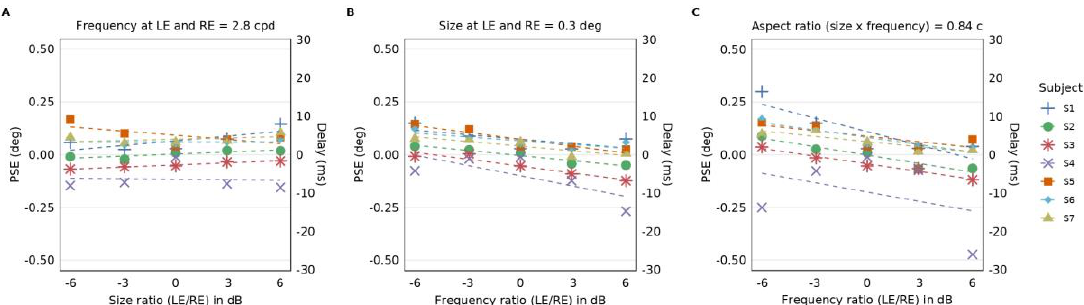
Figure 5. PSEs as a function of either size or spatial frequency ratio between the Gabor elements shown to the left and right eye. ( A ) Individual subjects’ PSEs (in degrees, left y -axis) as a function of the size ratio between the left and right eye’s Gabor elements when the frequency of the Gabor elements presented to both eyes is 2.8 c / d. Dotted lines represent linear regression for each subject. The slope from linear regression of PSEs as a function of the size ratio is not significantly di ff erent from zero (two-tailed Wilcoxon signed rank test: p = 0.47). Right y -axis represents the equivalent delay (in milliseconds). ( B ) Individual subjects’ PSEs (in degrees, left y -axis) as a function of the spatial frequency ratio between the Gabor elements when the size of the Gabor elements presented to both eyes is 0.3 deg. Dotted lines represent linear regressions for each subject. The slope from the linear regression as a function of the frequency ratio is significantly di ff erent from zero (two-tailed Wilcoxon signed rank test: p = 0.016). ( C ) Individual subjects’ PSEs (in degrees, left y -axis) as a function of the frequency ratio between the Gabor elements shown to the left and right eye when the aspect ratio remains at 0.84 cycles for both eyes. The aspect ratio is the product of spatial frequency and size. Dotted lines represent linear regression for each subject. As the spatial frequency of the Gabor elements shown to the left eye gets lower relative to that shown to the right eye, PSE becomes more positive. We observe that the linear regression slope is significantly di ff erent from zero (two-tailed Wilcoxon signed rank test: p = 0.016).